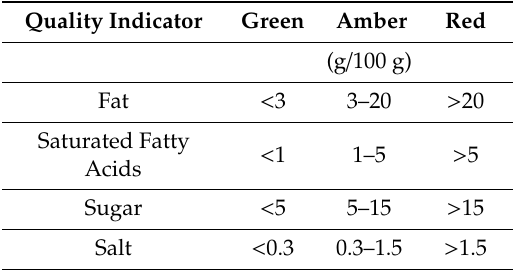
Table 2. Criteria for tra ffi c light labelling of foods in